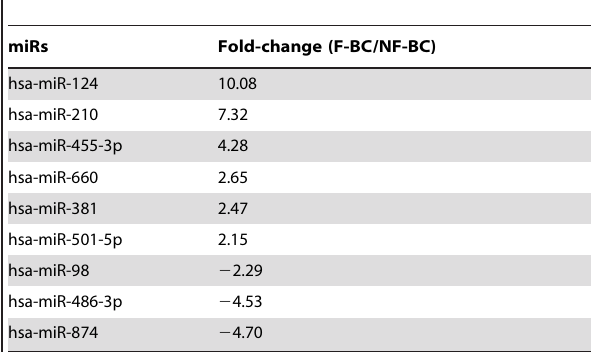
Table 3. MiRs differentially expressed between F-BC and NF-